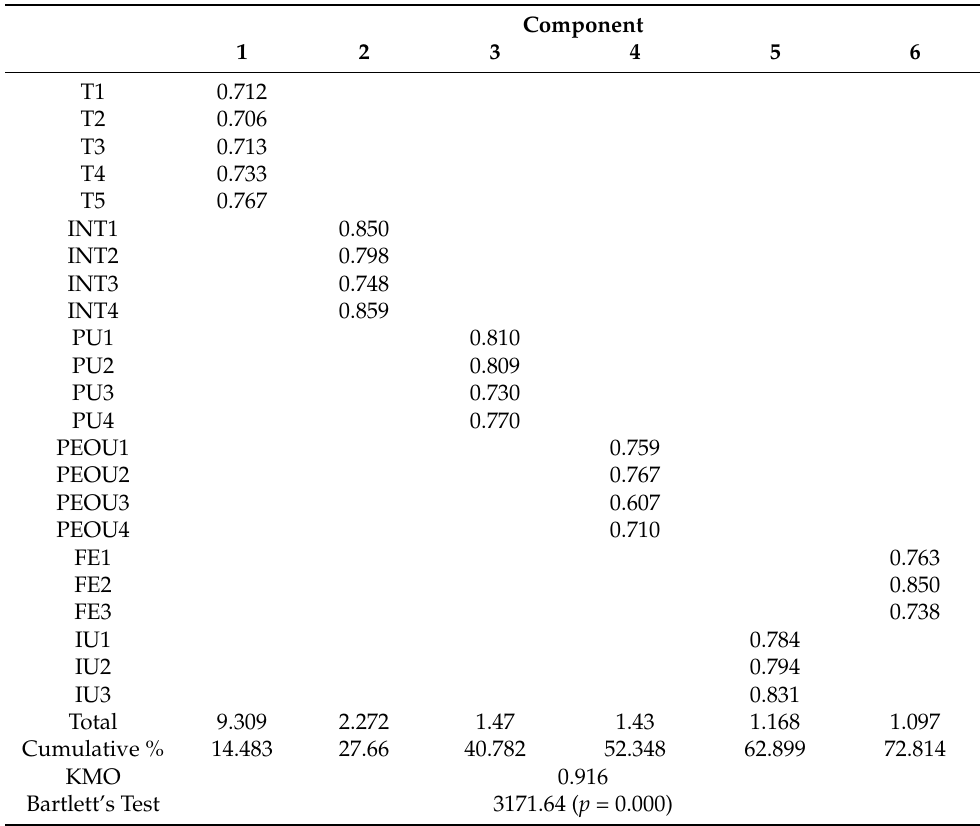
Table 3. Validity analysis results of